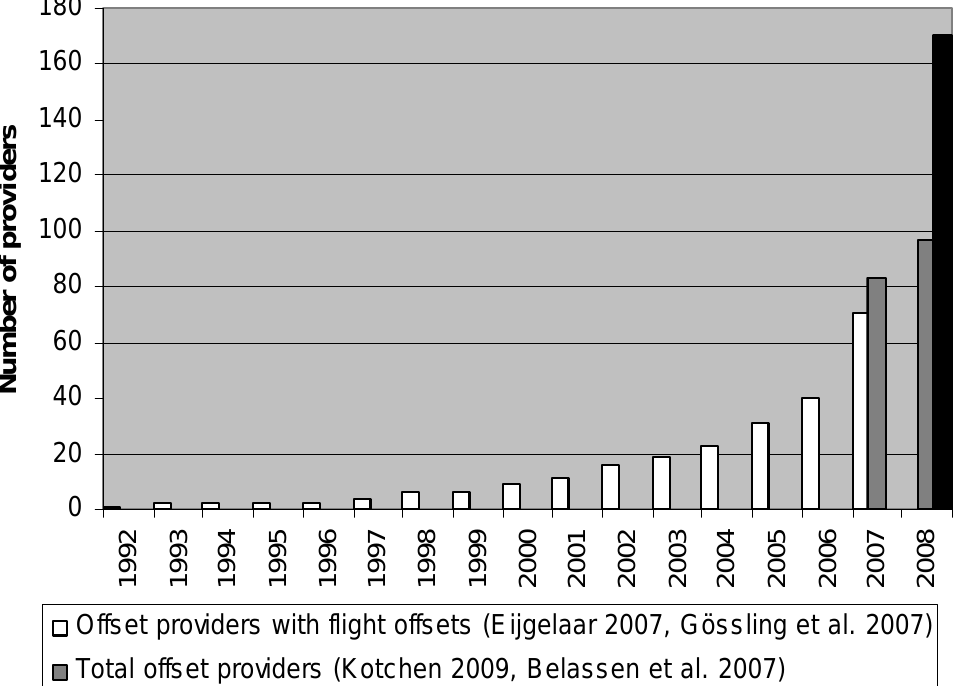
Figure 1. Number of voluntary carbon offset